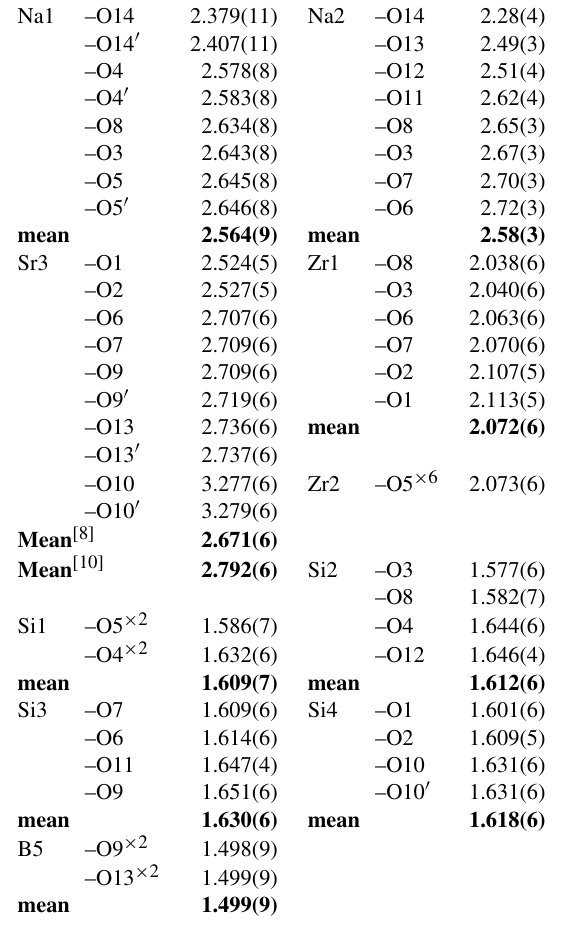
Table 5. Selected bond lengths (Å) for